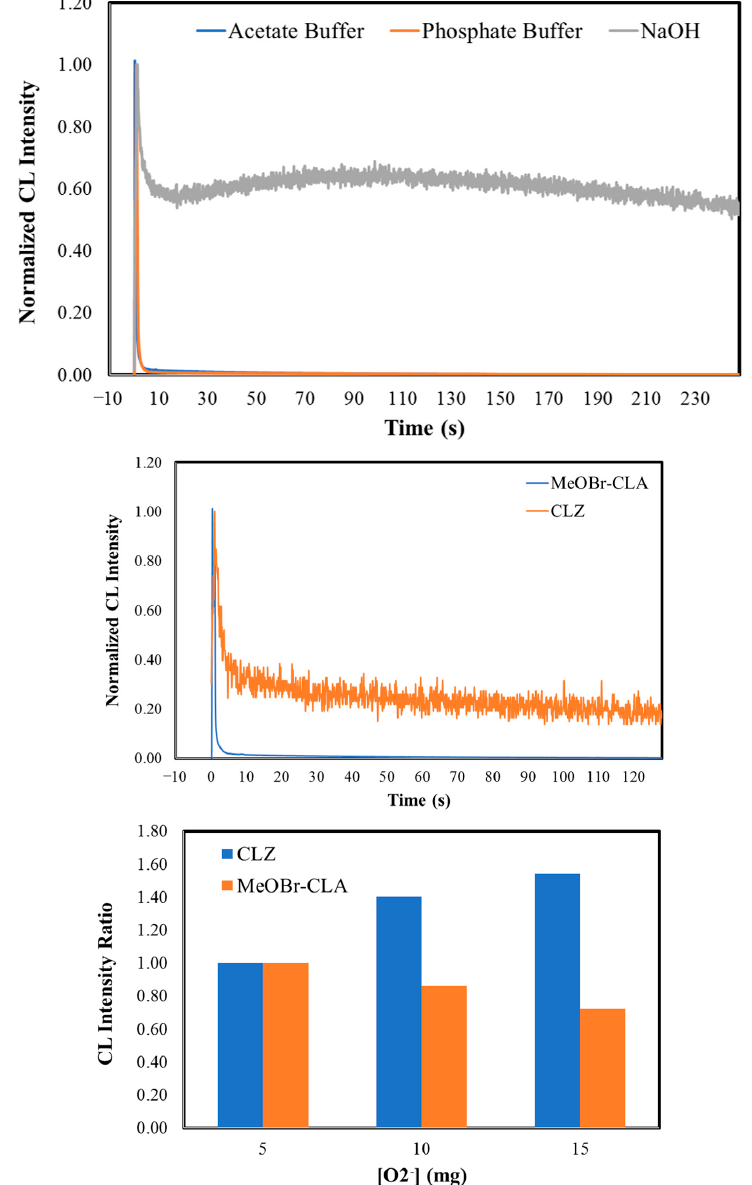
Figure 2. Normalized CL kinetic profiles for MeOBr-Cla in aqueous solutions with the addition of either sodium acetate buffer pH 5.2 (1%), phosphate buffer pH 7.4 (75 mM), or NaOH (0.1 M), in the presence of 10 mg of potassium superoxide (top). Normalized CL kinetic profiles for both MeOBr-Cla and Clz in aqueous solution with the addition of phosphate buffer pH 7.4 (75 mM), in the presence of 10 mg of potassium superoxide (middle). CL intensity ratios for the CL reactions of both Clz and MeOBr-Cla in aqueous solutions with the addition of sodium acetate buffer pH 5.2 (1%), in the presence of increasing amounts of potassium superoxide (5 to 15 mg). The CL intensities obtained for each molecule in the presence of 5 mg of potassium superoxide were used as a reference for Clz and MeOBr-Cla (bottom). All assays were performed for a final volume of 500 μ L and a concentration of 5 μ M of Clz/MeOBr-Cla.